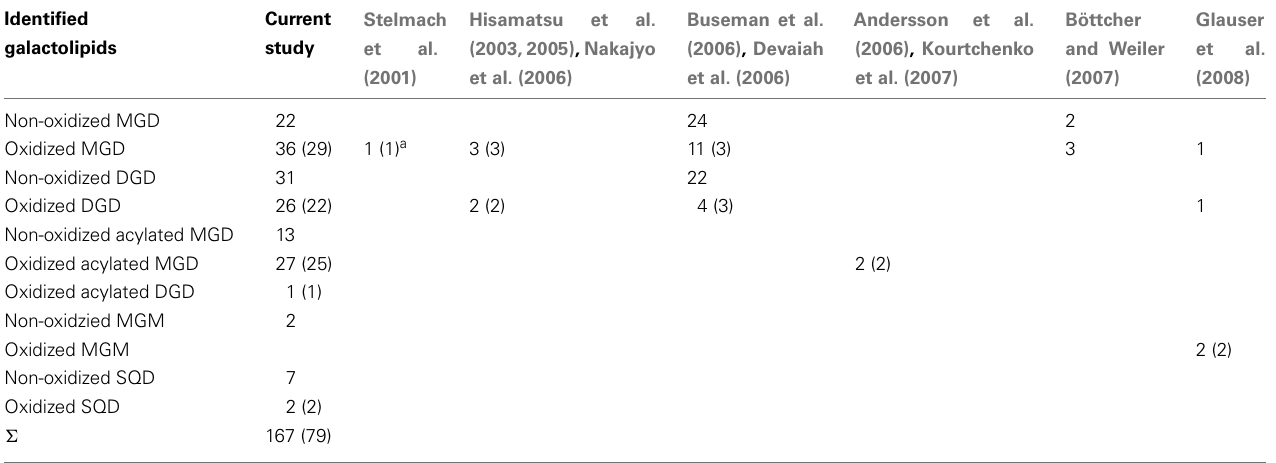
Table 6 | Number of identified galactolipid species detected in wounded leaves of A.